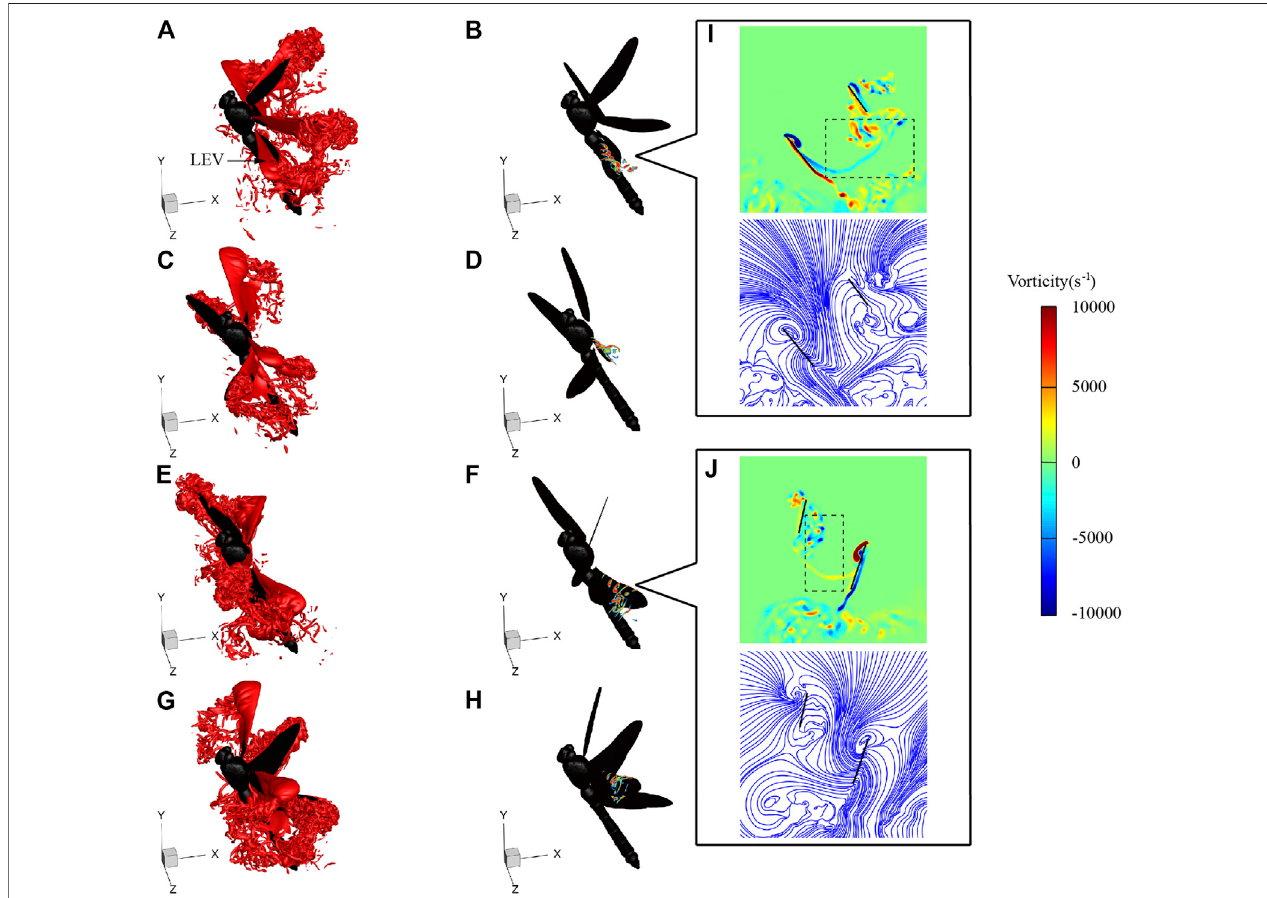
FIGURE9| VortexstructuresofLD1at115 ms[ (A) and (B) ],118 ms[ (C) and (D) ],122 ms[ (E) and (F) ],and125 ms[ (G) and (H) ].Vorticitycontourandstreamlines of the r 2 section at 115 ms (I) and 122 ms (J)